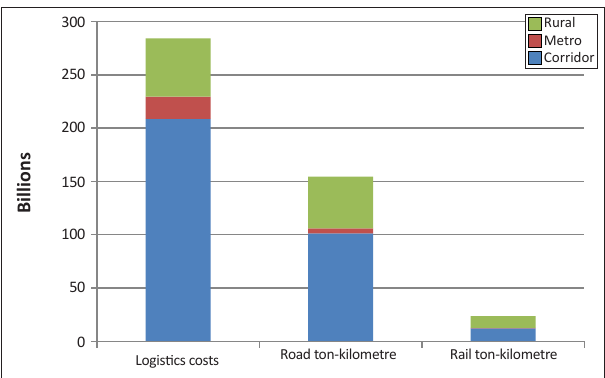
FIGURE 5: Competitive typology magnitude in logistics costs and ton-kilometre (2011).